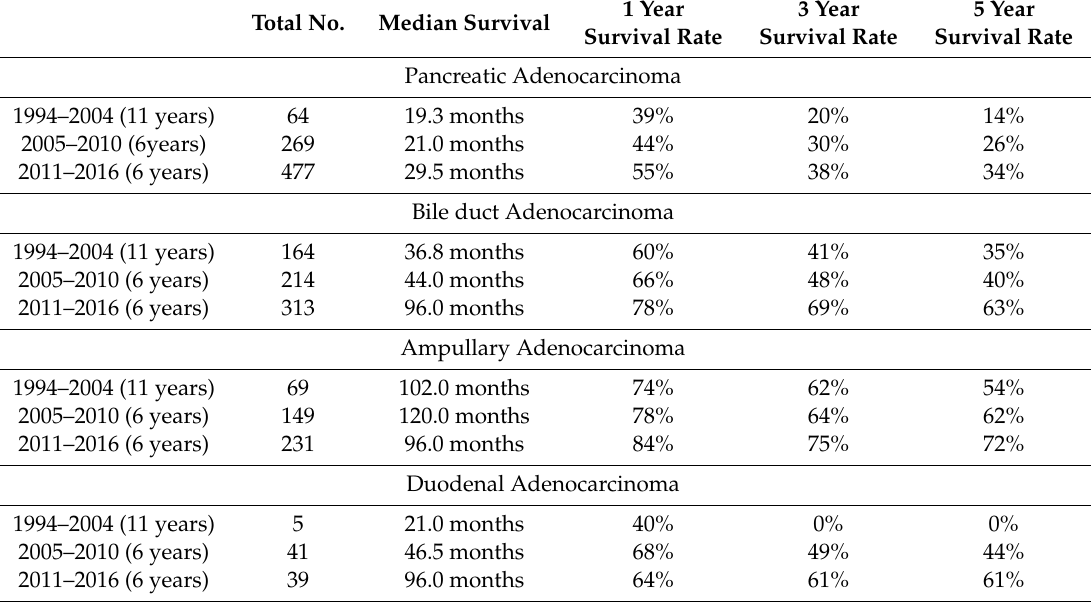
Table 5. Chronologic di ff erences of survival rates for those with each adenocarcinoma from 1994 to